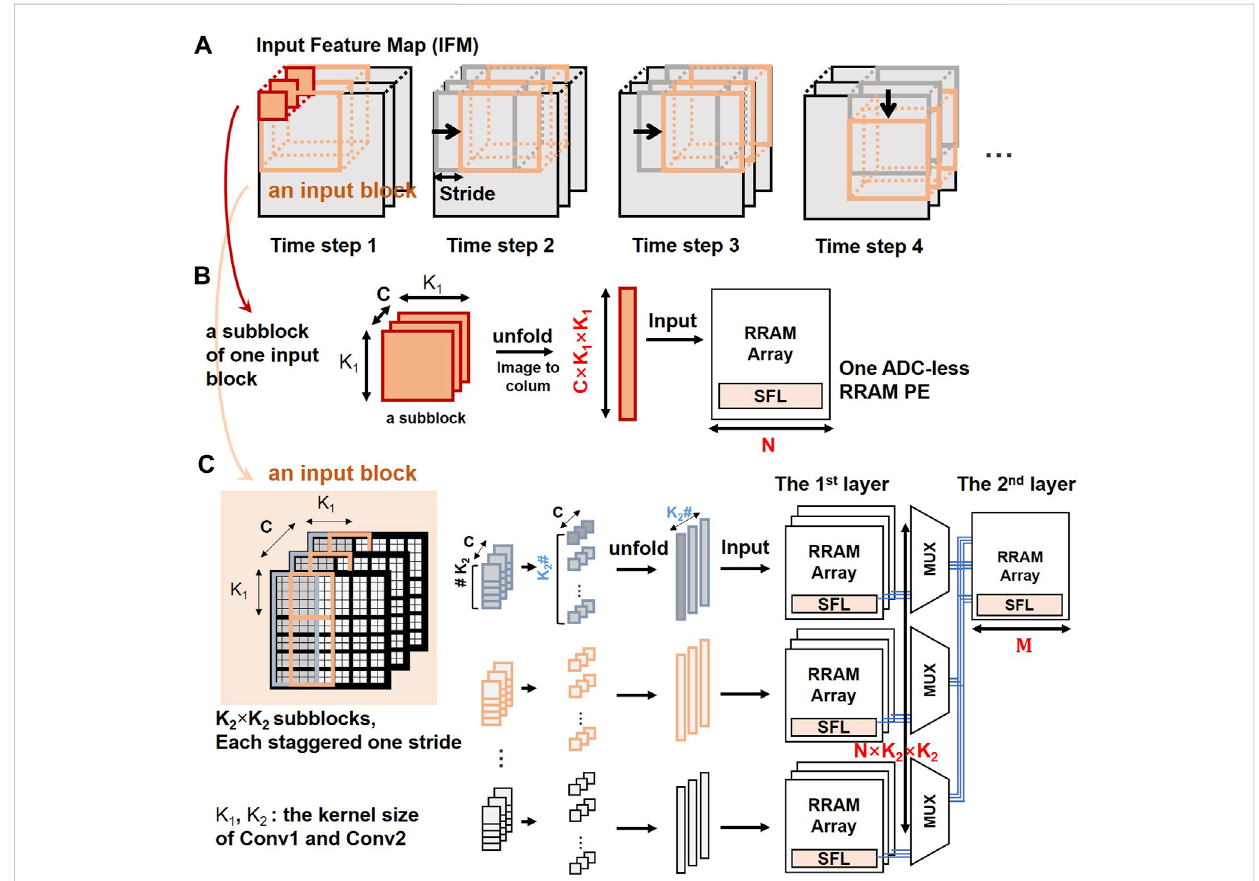
FIGURE 5 Theblockwisemappingmethodanddata fl owfortwoconsecutiveconvolutionallayers. (A) Ateachtimestep,theinputblockmovesbyonestridein the IFM; (B) Each subblock is unfolded and input to an ADC-less RRAM PE; (C) Only the new K 2 subblocks will be calculated and N × K 2 × 1 results are updated into C MEM .